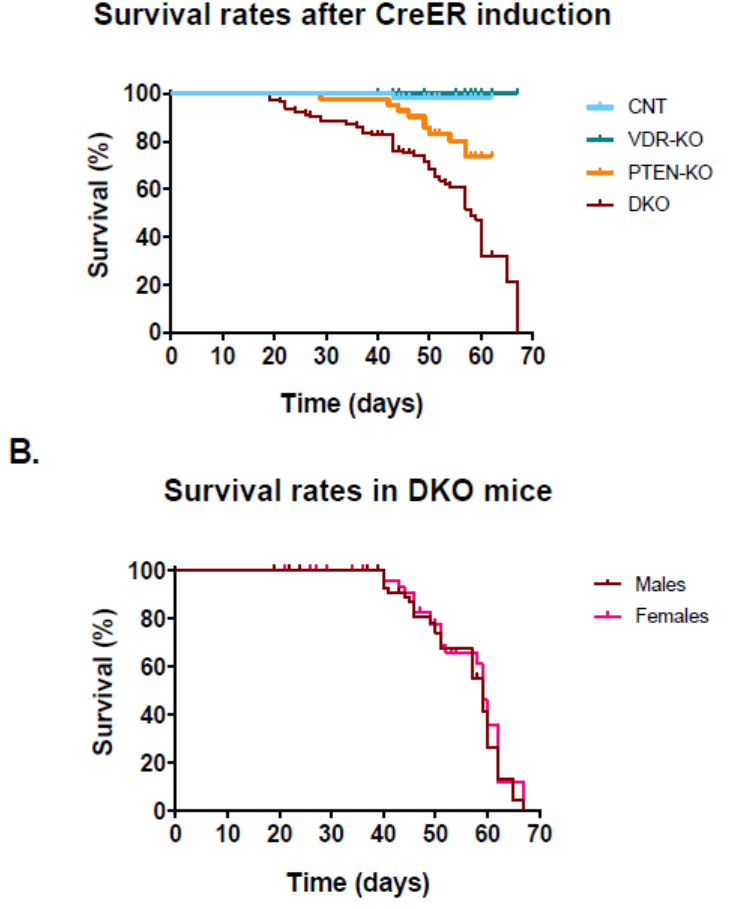
Figure 1. Survival rates after Cre-induced PTEN ablation. ( A ) The 65-day follow up after tamoxifen injection showed a 98.2% survival rate in CNT (54 of 55), 100% in VDR-KO (42 of 42), 76.2% in PTEN-KO (32 of 42) and 0% in DKO (0 of 59); long-rank test p < 0.001. ( B ) Survival rate was not influenced by sex; Long-Rank test p = 0.472. CNT: Control. VDR-KO: Vitamin D receptor knockout. PTEN-KO: Phosphatase and tensin homolog knockout. DKO: Double knockout.